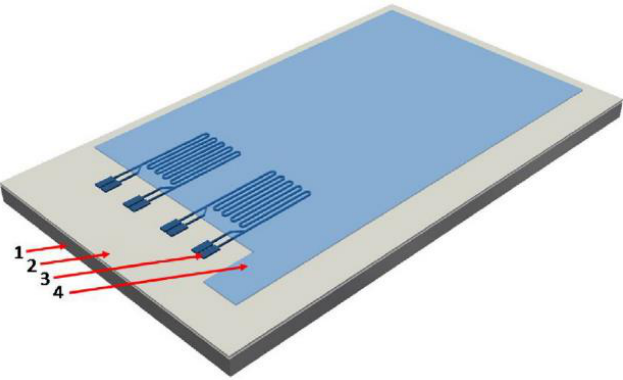
Figure 26. Example of a screen-printed strain gauge embedded in an organic coating. (Reprinted with permission from ref. [123]. Copyright 2018 Elsevier).